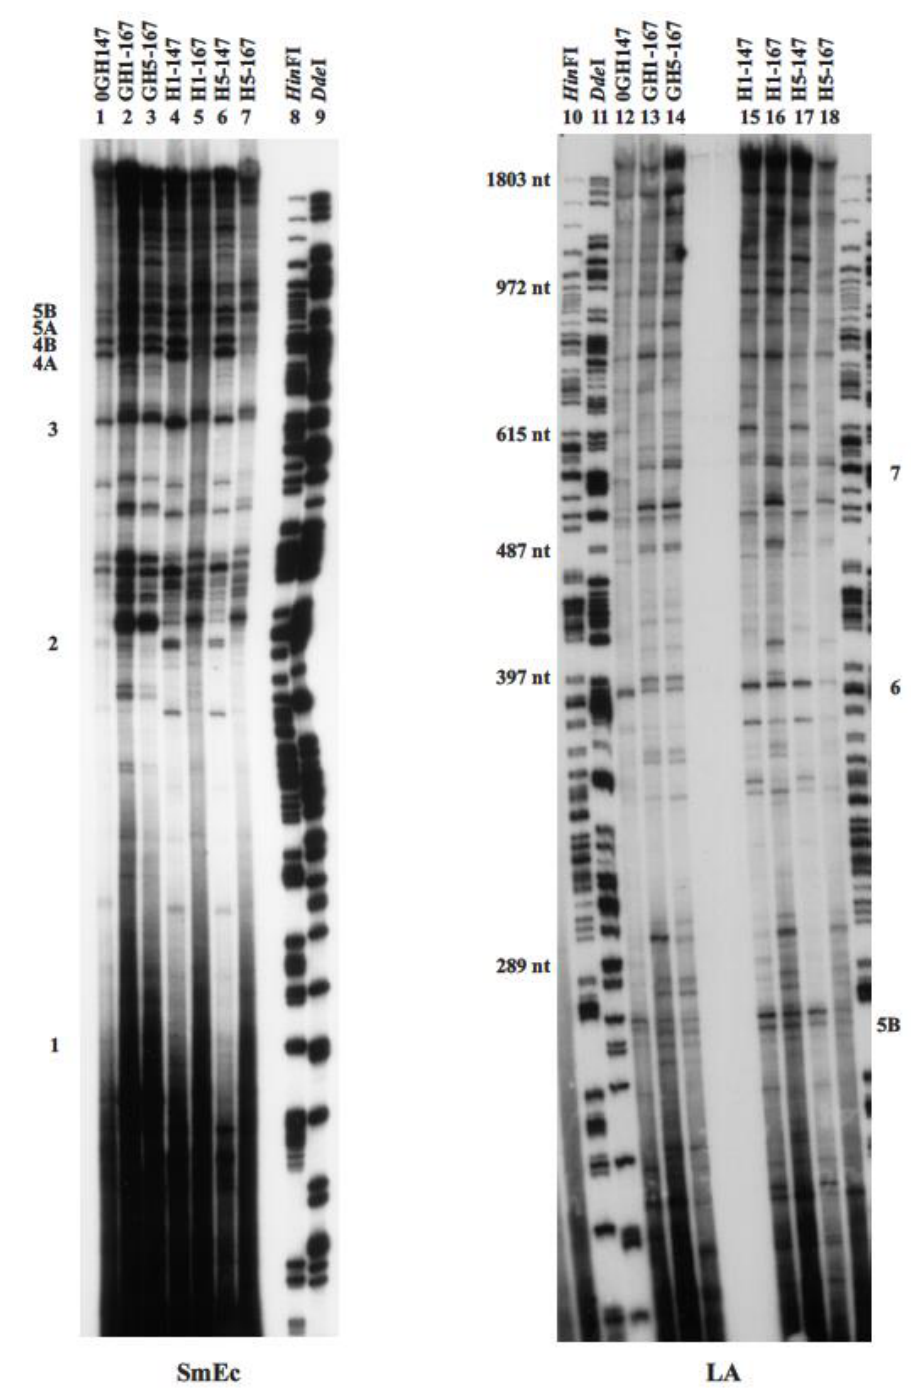
Figure 4. A 6% denaturing polyacrylamide gel analysis of monomer extension products formed on mapping constructs SmEc and LA from linker histone globular domains or linker histones reconstitutes. H1-147: core particle DNA derived from H1-containing reconstitutes. H1-167: chromatosomal DNA derived from H1-containing reconstitutes. H5-147: core particle DNA derived from H5-containing reconstitutes. H1-167: chromatosomal DNA derived from H5-containing reconstitutes. The names for samples from linker histone globular domain reconstitutes were as described in Figure 1. Size standards were as described in Figure 2. Prominent core particle positioning sites or groups of sites previously identified were numbered as in Davey et al. (1995)